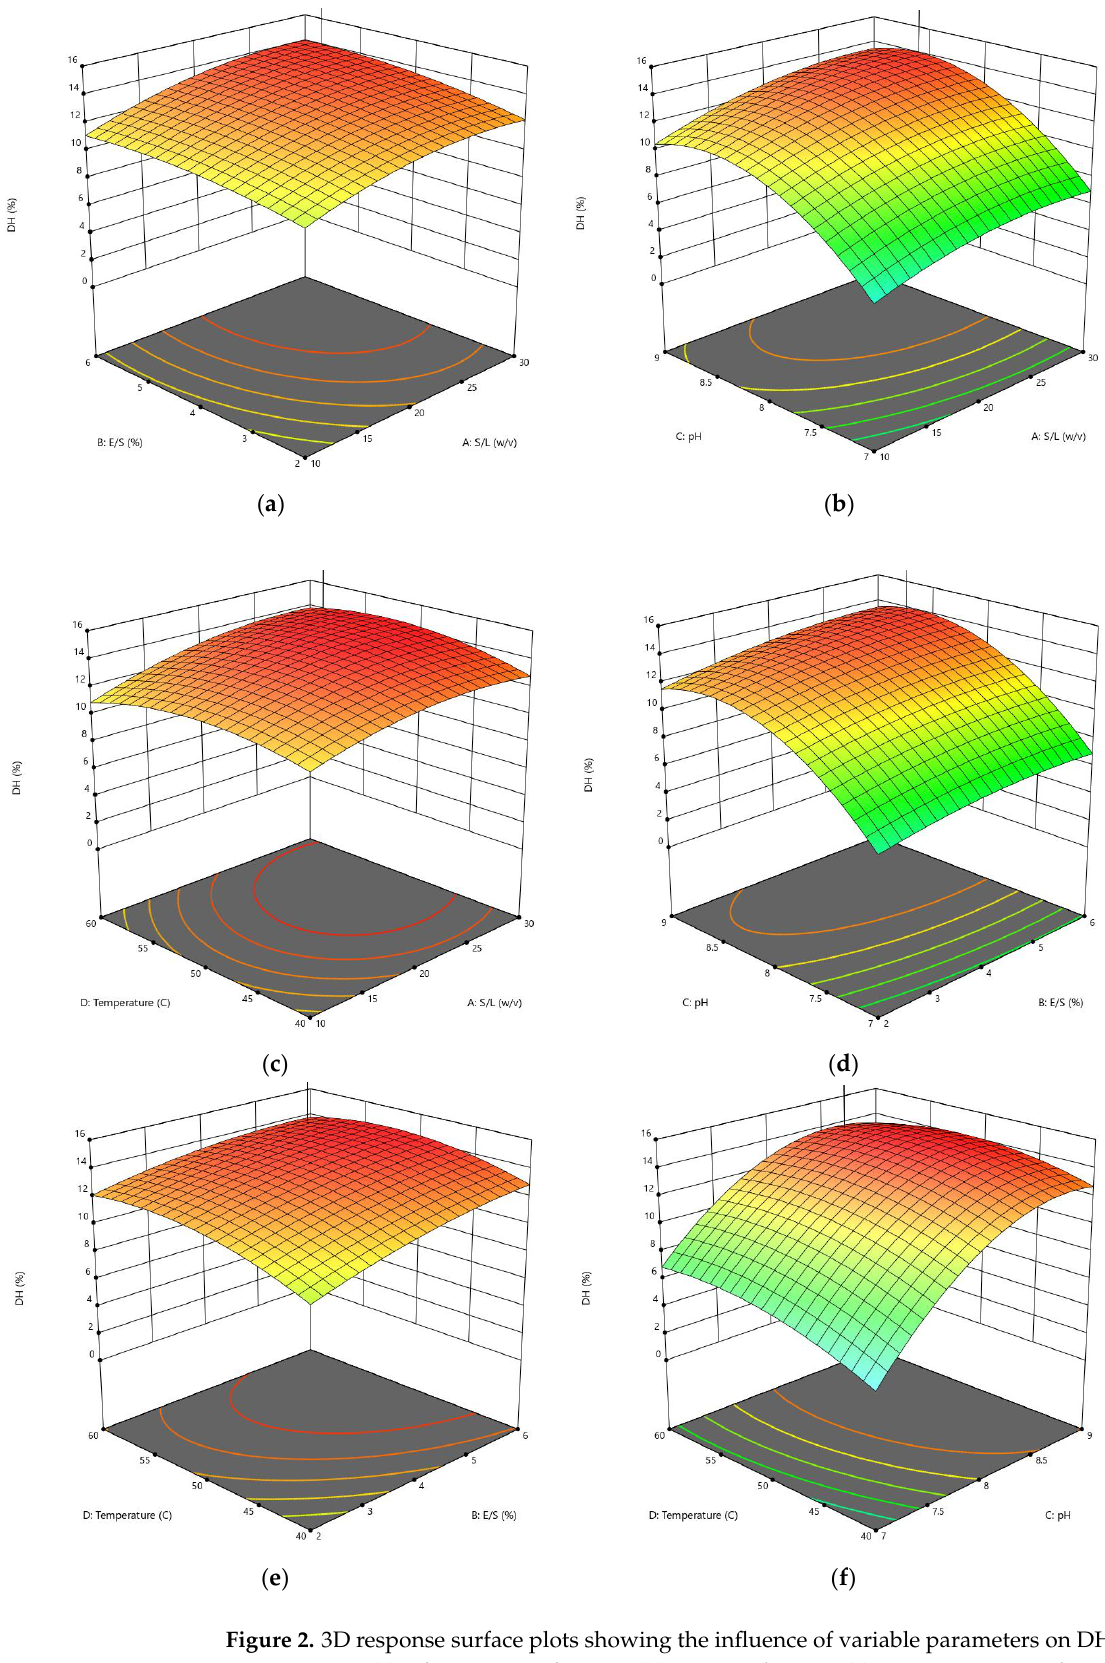
Figure 2. 3D response surface plots showing the influence of variable parameters on DH response using trypsin: ( a ) E/S ratio vs. S/L ratio, ( b ) pH vs. S/L ratio, ( c ) temperature vs. S/L ratio, ( d ) pH vs. E/S ratio, ( e ) temperature vs. S/L ratio and ( f ) temperature vs. pH.